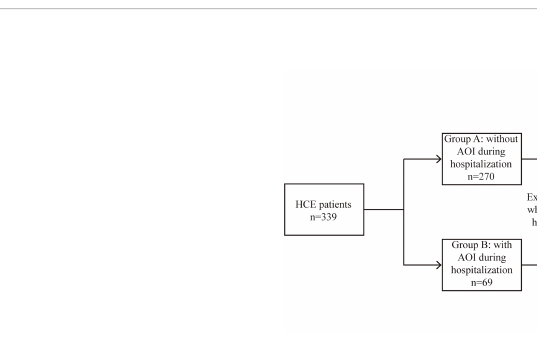
FIGURE 1 A fl ow chart describing the study